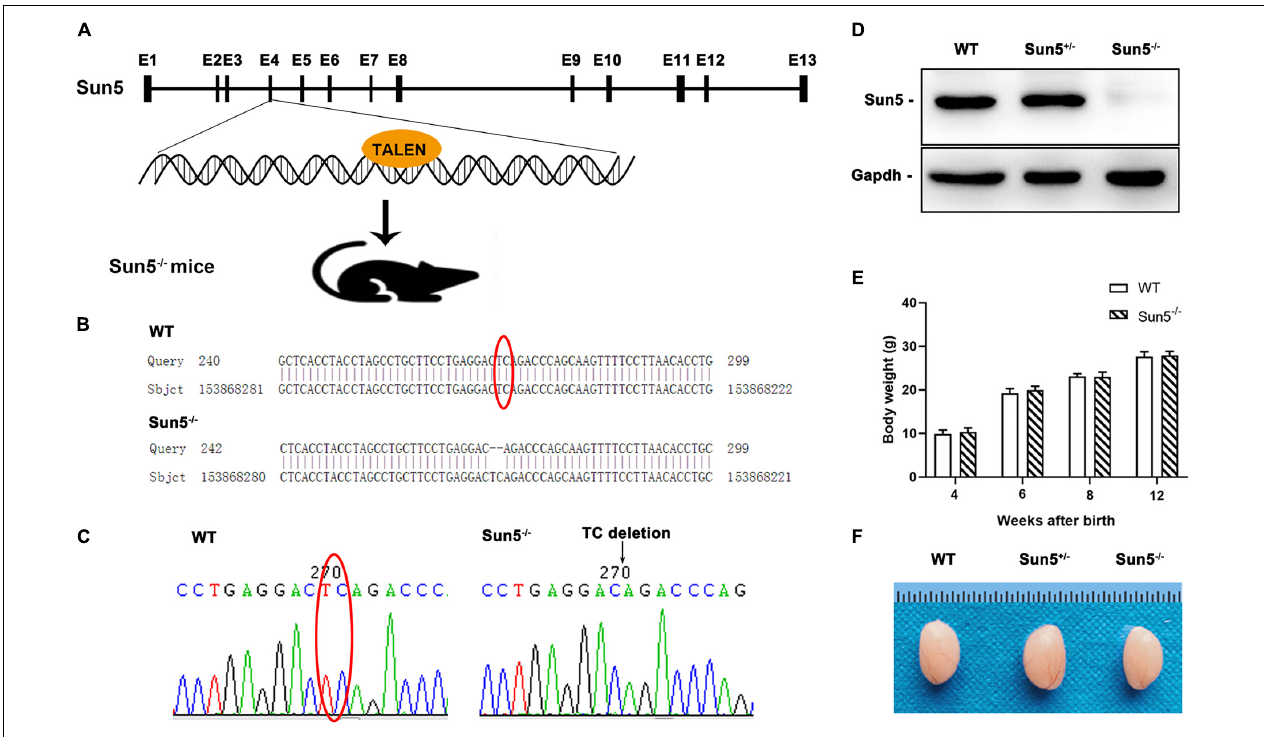
FIGURE 1 | Generation of Sun5 − / − mice. (A) Schematic illustration of the Sun5 − / − mouse knockout strategy. (B,C) Sequences of the knockout alleles in Sun5 − / − mice determined by Sanger sequencing. (D) Western blot results showing the absence of Sun5 proteins in the testes of Sun5 − / − mice but detection in WT and Sun5 + / − mice. Gapdh served as a loading control. (E) Similar body weights of WT and Sun5 − / − mice during the growth process. Data are presented as the mean ± SEM, n = 3. (F) Similar gross morphology of the epididymis in WT, Sun5 + / − and Sun5 − / − mice.